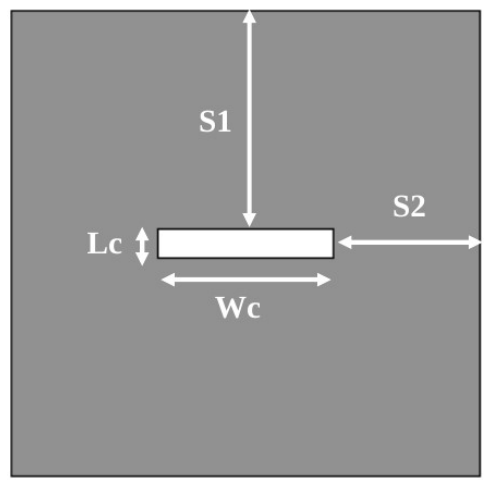
Figure 6. Patch with CRS